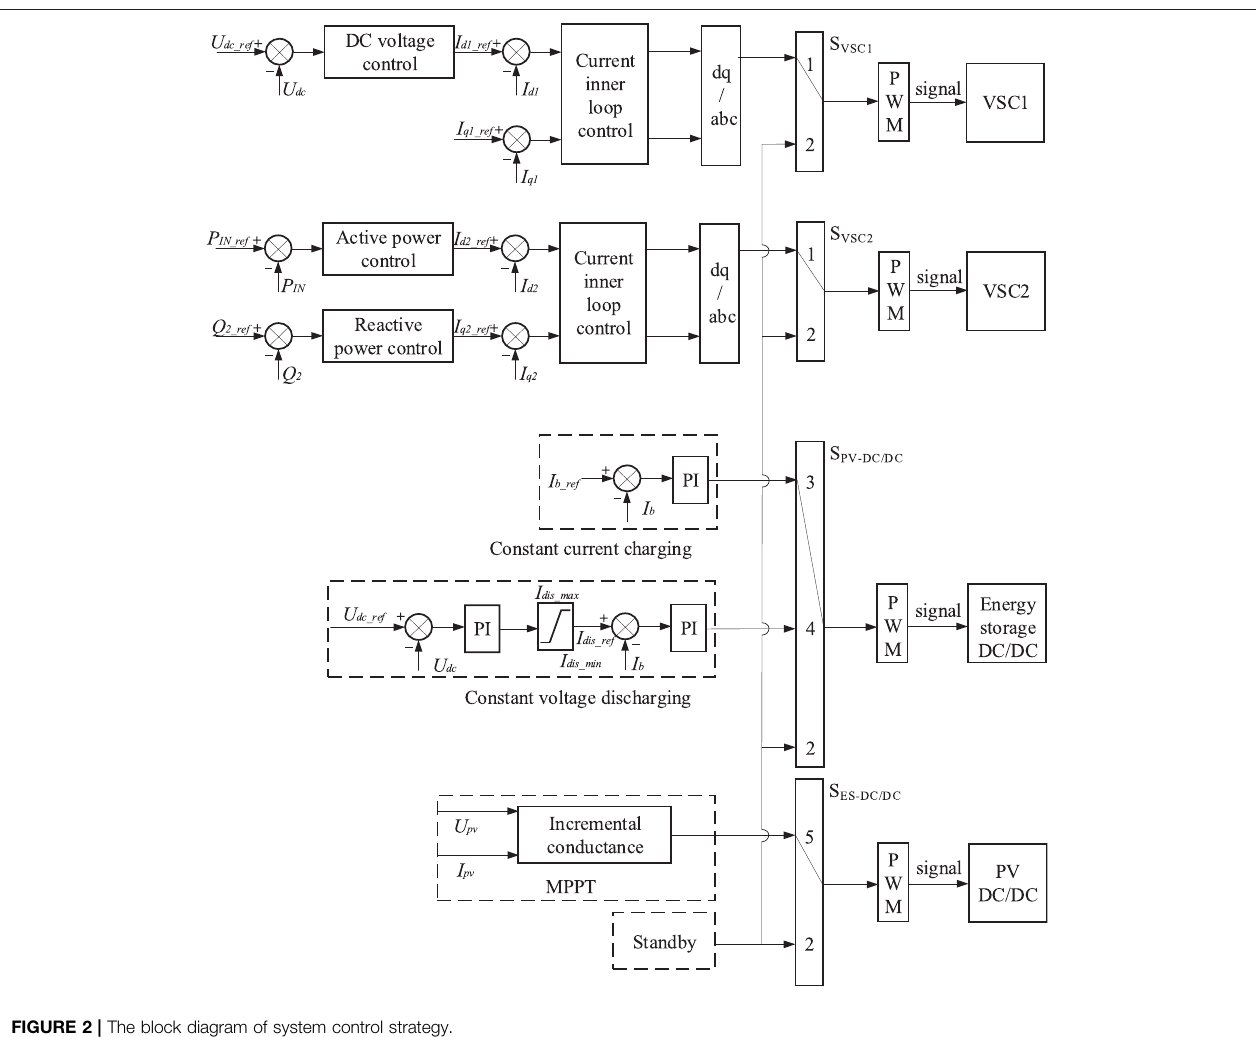
FIGURE 2 | The block diagram of system control